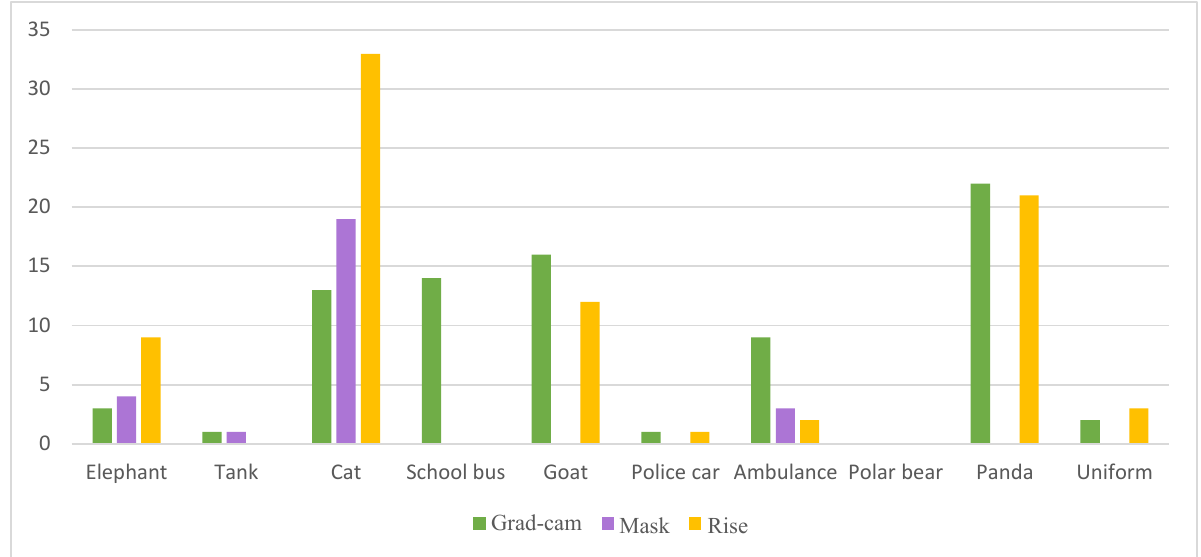
Figure 12. The statistical result of the correct object name given by the user. Each interpretation method is tested with 10 images from DataS and 35 users.